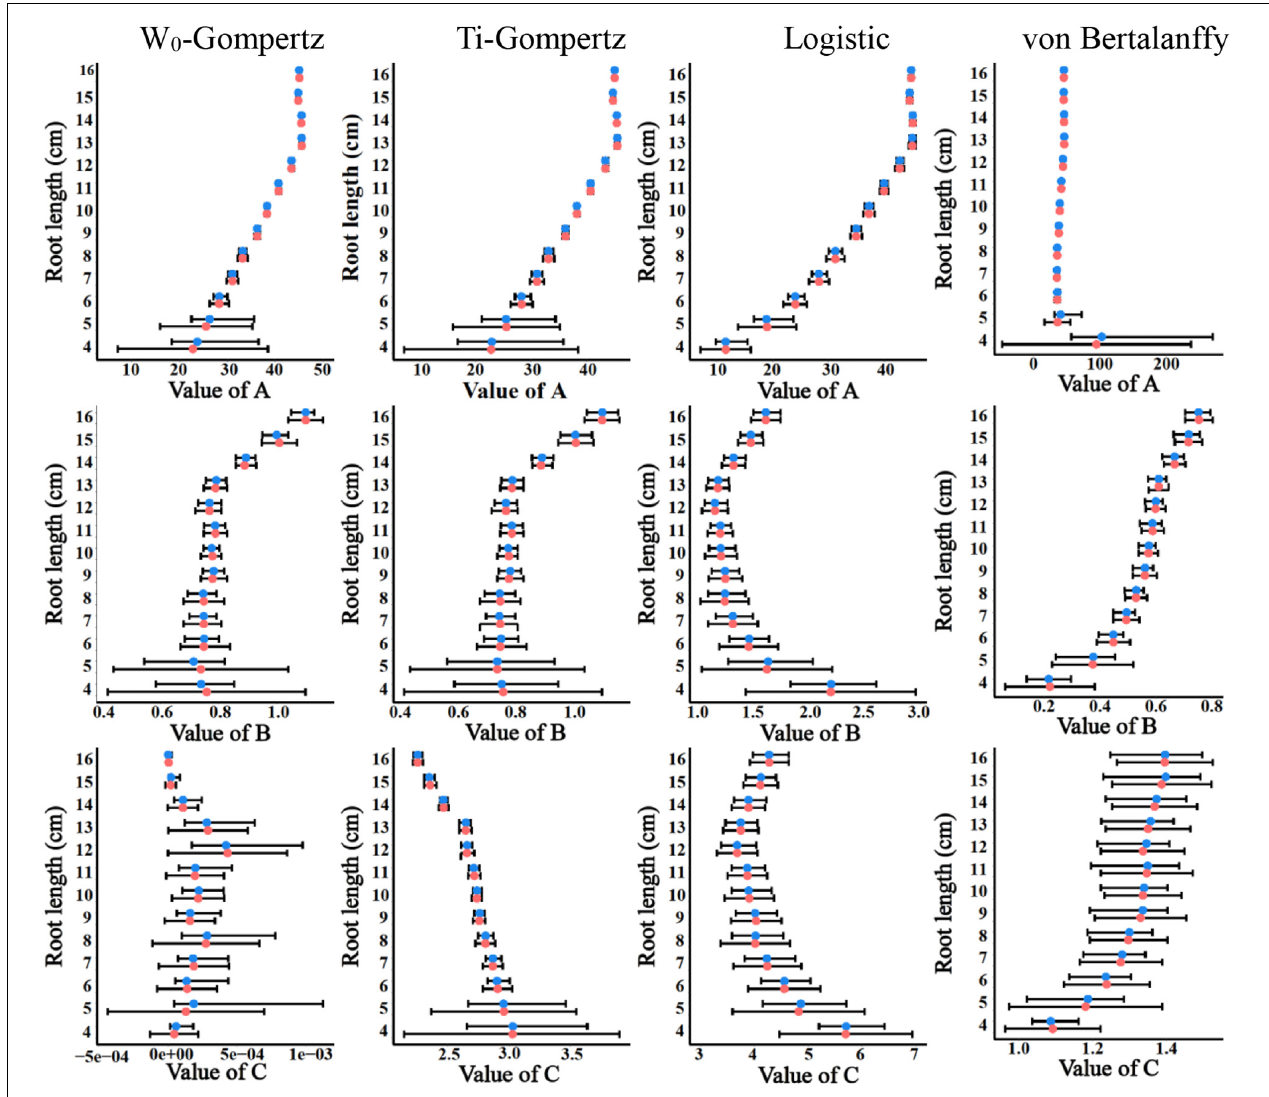
FIGURE 3 | The estimates and their 95% CIs of the parameters A , B , and C obtained by the ordinary least squares (red points) and bootstrap-based estimates (blue points) of the W 0 -Gompertz, Ti-Gompertz, logistic, and von Bertalanffy models fit to the aerenchyma percentage in rice adventitious roots with different